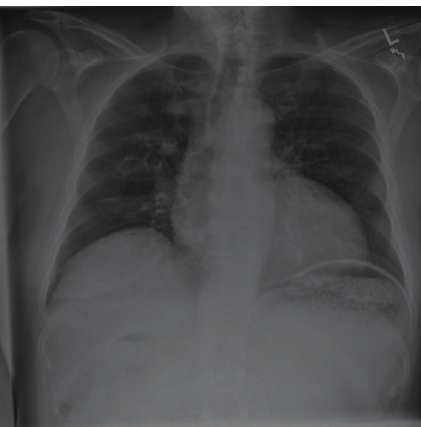
Figure 2: Abdominal X-ray showing dilated and partially fluid- filled stomach.